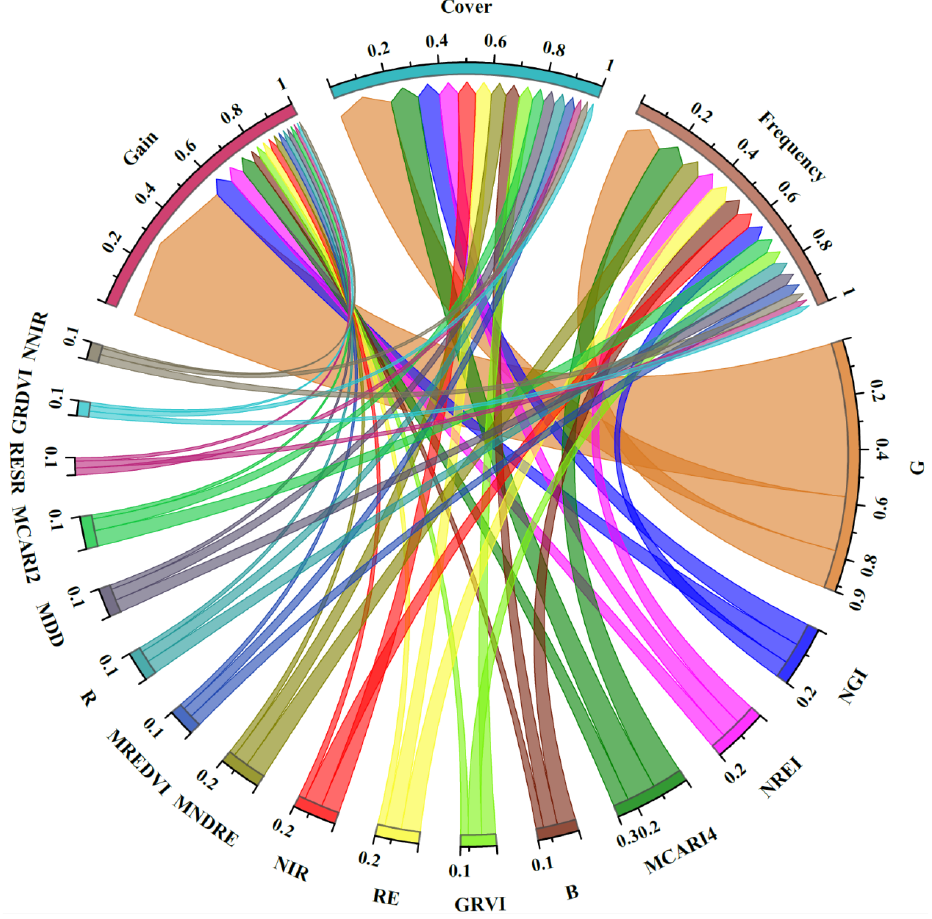
Figure 6. Relationship between features and AGB based on the GOA-XGB2 model.